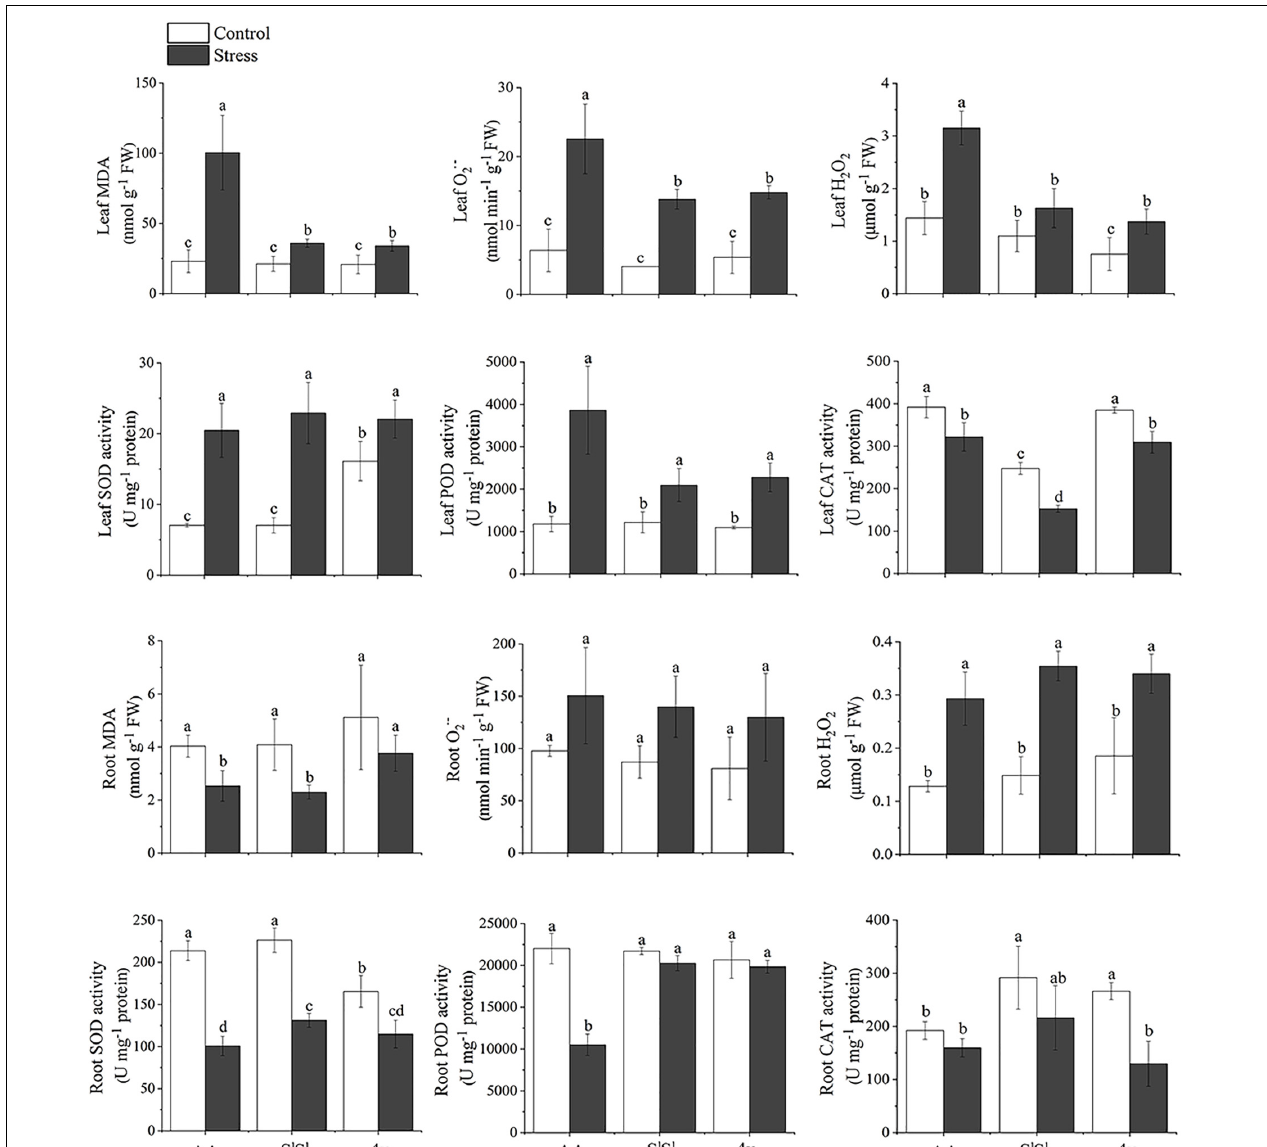
FIGURE 2 | Effects of salinity stress on antioxidant systems of the synthetic tetraploid wheat and its diploid parents. The seedlings were exposed to 150 mM NaCl for 7 days. The values are mean ( ± SD) of three biological replicates. Different letters above bars denote significant differences among the lines and treatments according to t -test ( P <